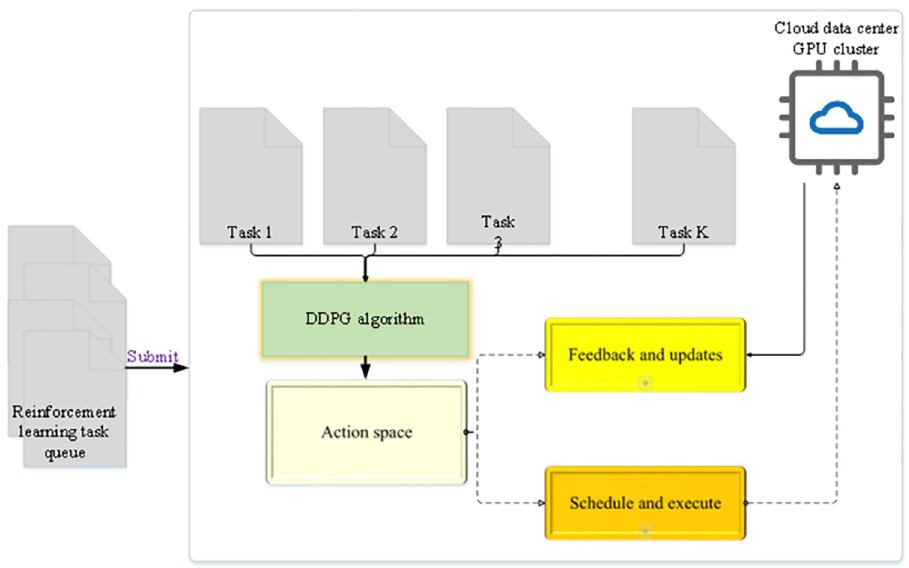
Fig 6. Cloud task scheduling strategy based on the improved DDPG algorithm.